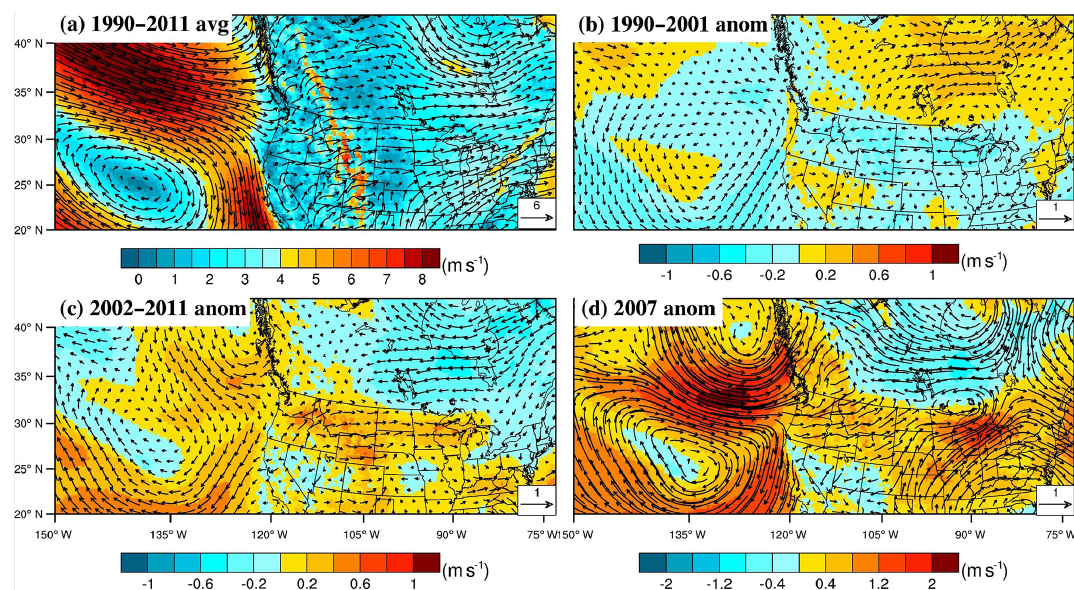
Figure 4. The mean wind vector and speed (shading area) during 1990–2011 (a) and the anomalies of wind vector and wind speed (shading area) during 1990–2001 (b) , 2002–2011 (c) , and 2007 (d) at 925hPa over western coastal Canada and the US (the anomalies in b , c , and d were conducted relative to the 20-year period of 1990–2009 and the wind vector and wind speed were from the North American Regional Reanalysis (NARR) with a spatial resolution of 32km by